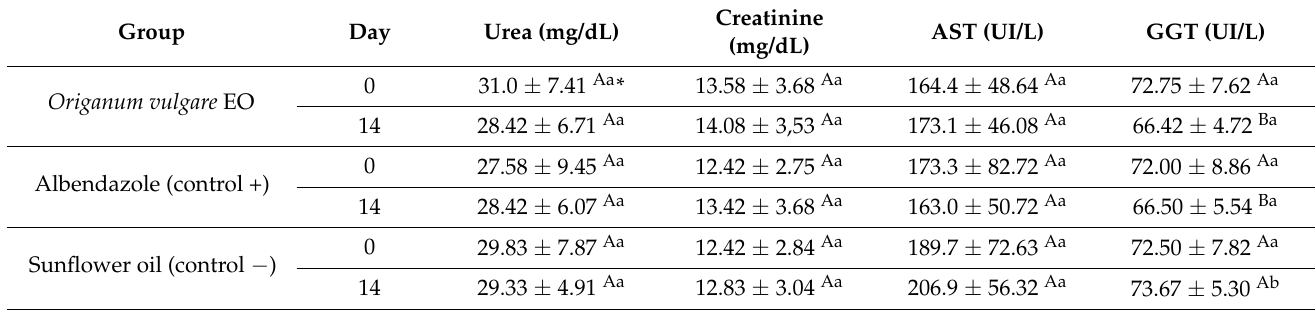
Table 4. Impact of the Origanum vulgare essential oil on the parameters that indicate kidney and liver function in tested animals—in total from both examined farms.